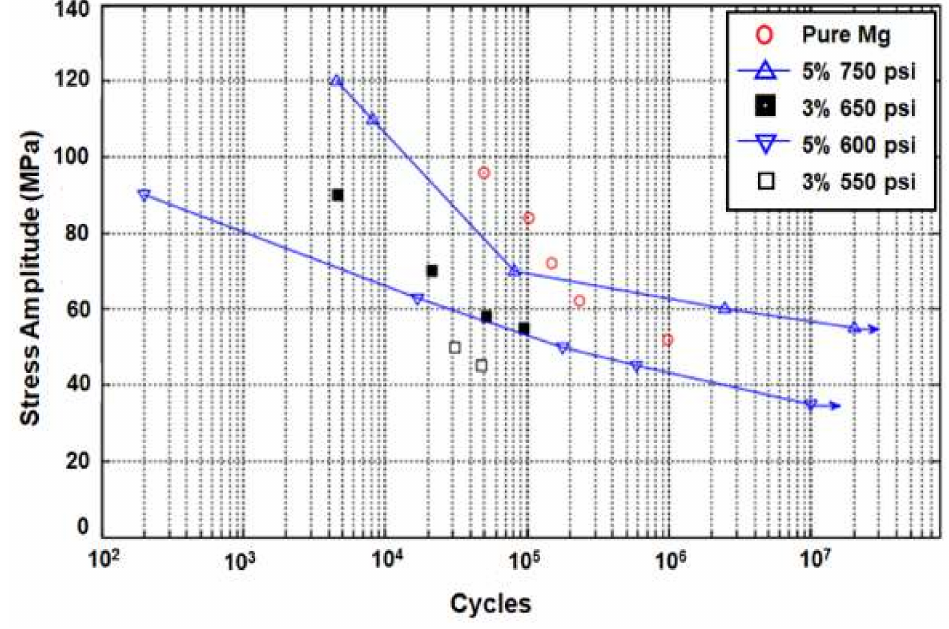
Figure 15. S–N curve of Mg-NiNb composites under fatigue loading conditions [39]. (© 2016, Elsevier. Used with